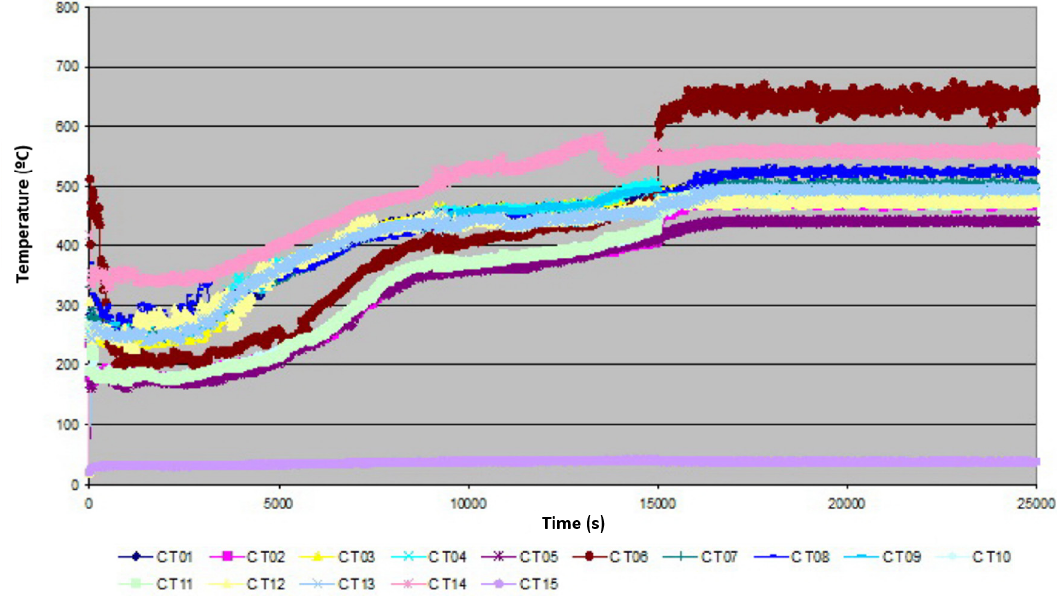
Figure 9. Evolution of the temperatures simulated with FDS.